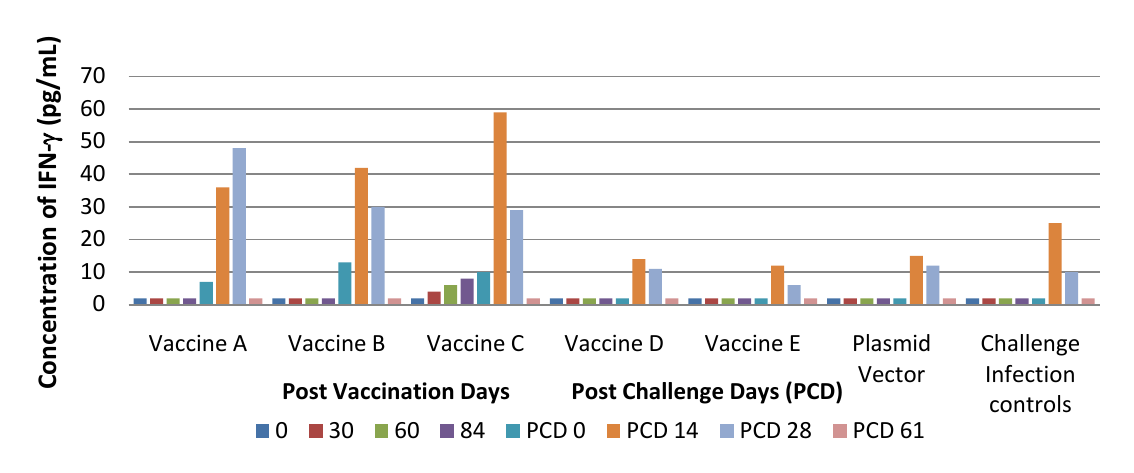
Figure 8. IFN-  response (pg/mL) in pigs immunised with experimental PRRS DNA vaccines and challenge infected with virulent